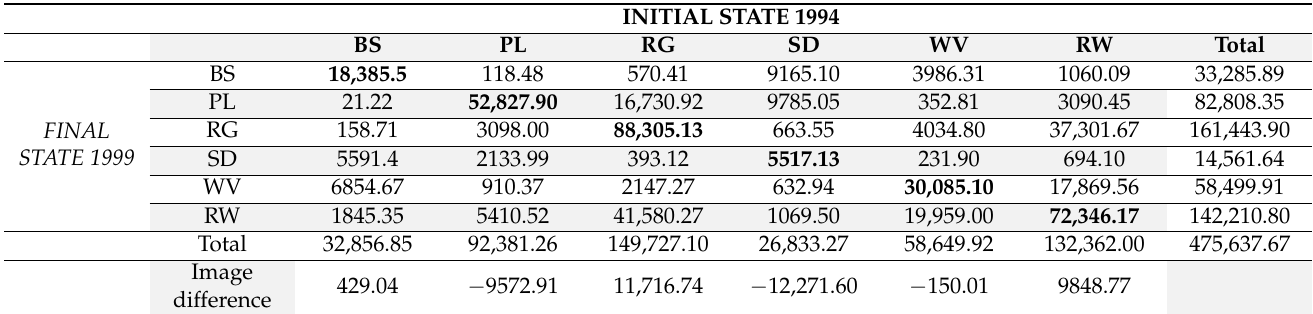
Table 5. Change matrix of the rainfed agriculture and other LULC types of North Darfur State in hectares from 1994 to 1999. The bold values in the change matrix indicate unchanged land types between the initial and final